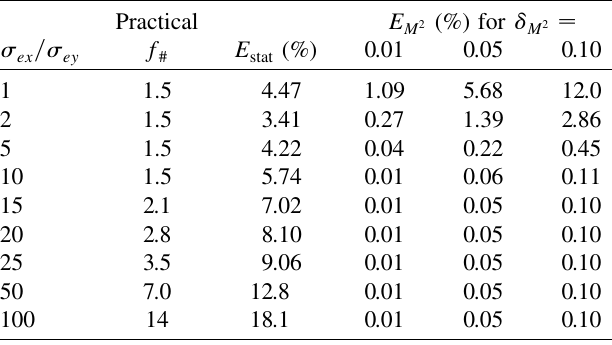
defined in Eq. (41) for a set of (cid:14)